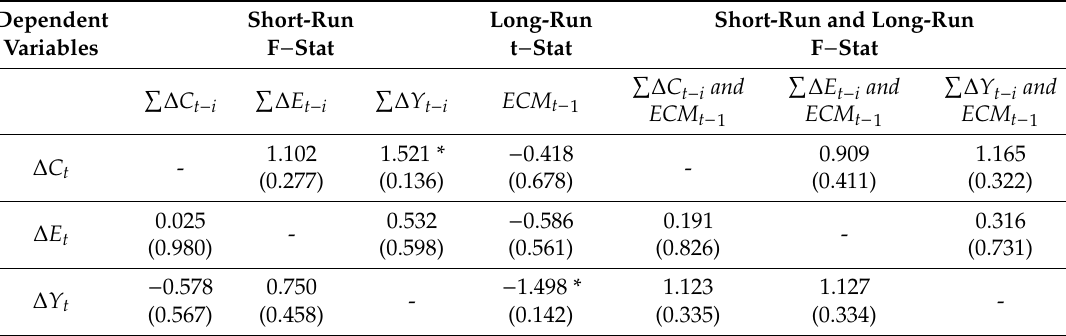
Table 8. Causality results (Philippines).